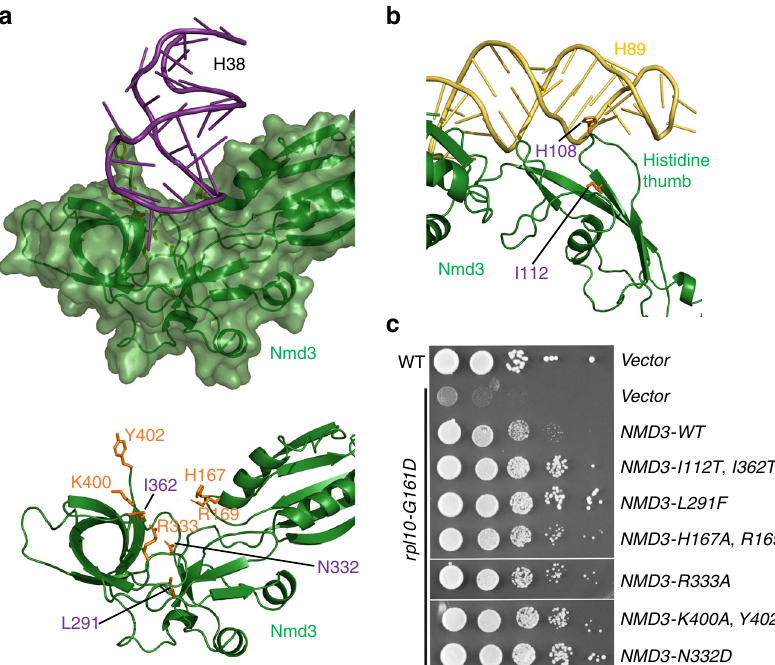
Fig. 4 Release of H38 and H89 from Nmd3 stabilizes Rpl10 (uL16) in the ribosome. a Atomic structure showing that H38 lays in a saddle of Nmd3 (top). Lower panel, selected residues highlighted in orange sit in the immediate interface between Nmd3 and H38. L291, N332, and I362 (purple) were previously identi fi ed from genetic screens for suppressors the temperature-sensitive rpl10-G161D mutant. b Atomic structure showing that interaction of the histidine thumb of Nmd3 with H89. H108 and I112 were identi fi ed from genetic screens rpl10-G161D suppressors. c Wild-type (WT) or rpl10-G161D mutant cells were transformed with empty vector or vector expressing WT or the indicated NMD3 mutants. Ten-fold serial dilutions of cultures were plated onto selective plates and incubated for 2 days at 30 °C, a semi-permissive temperature for rpl10-G161D . The mutations H167A, R169A, R333A, K400A, and Y402A in NMD3 were engineered based on the structural information as indicated in ( a